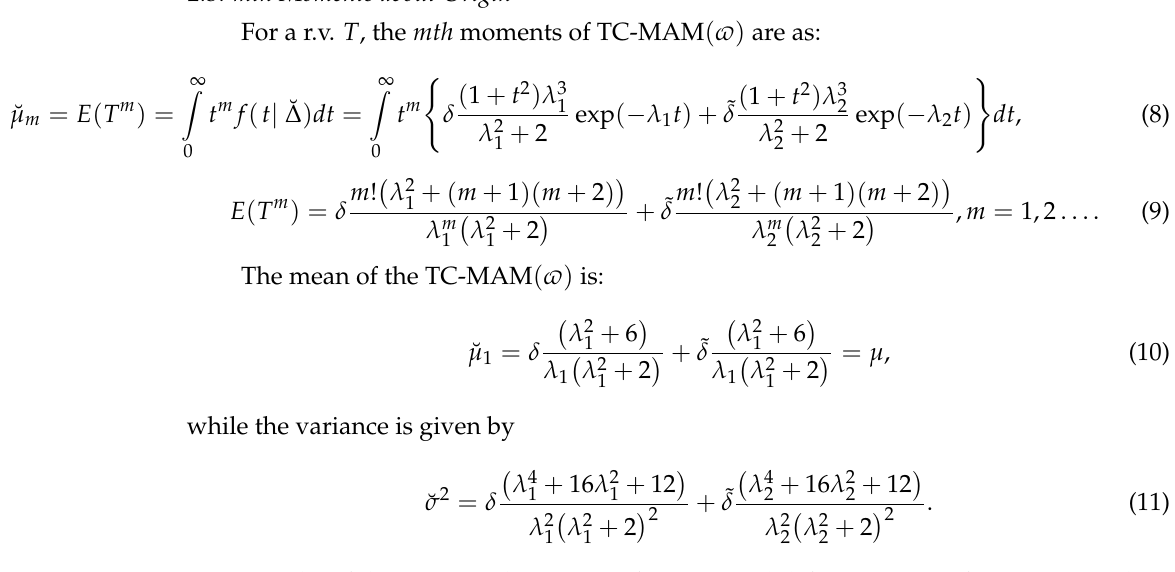
Figure 2. Behavior of F 1 ( t | λ 1 ) (first component CDF), F 2 ( t | λ 2 ) (second component CDF) and CDF Fig. 2. Behaviour of F of TC-MAM ( F m ( t | (cid:118) ) ) with δ against t and CDF of TC-MAM ( F